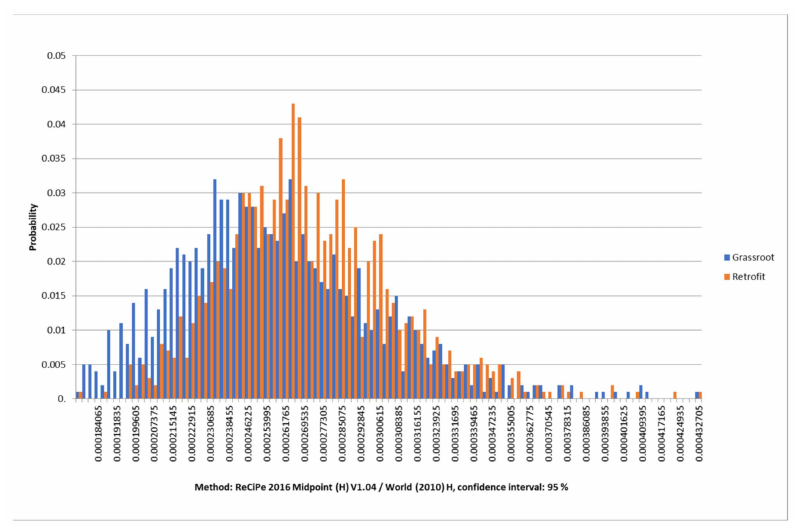
Figure 13. Distribution of probability index of